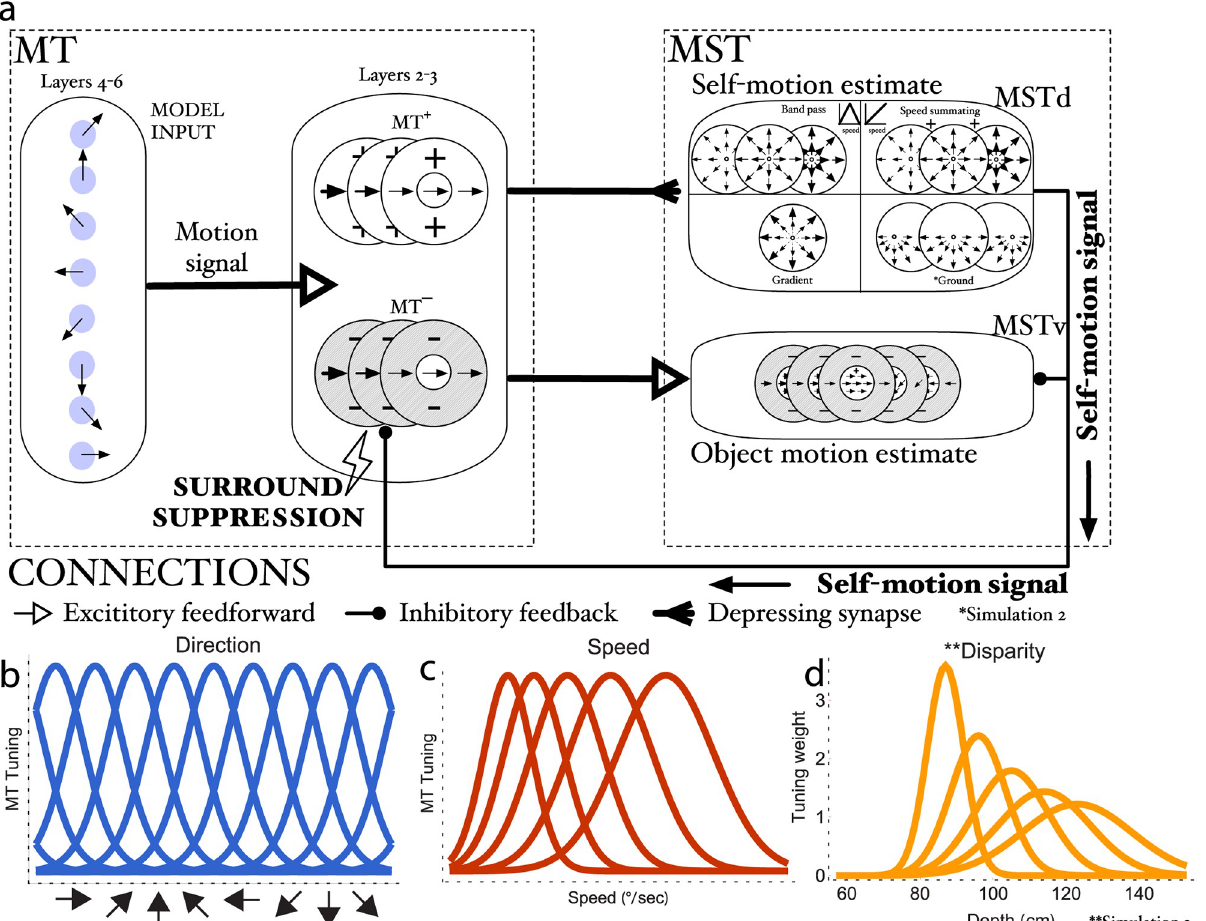
Fig 2. Diagram of model MT and MST. (a) The model contains two major pathways: MT + /MSTd subserves self-motion (top) and MT − /MSTv subserves object motion (bottom). The model is dynamic and estimates self-motion and object motion simultaneously. Cells in MSTd model physiologically supported populations tuned to full-field radial patterns, speed (band-pass, speed summating, gradient), and non-direction dependent disparities. Cells in MT − /MSTv have RFs with inhibitory surrounds due to local and feedback mediated suppression. Feedback comes from dominant MSTd units and suppresses MT − /MSTv units locally tuned to the direction, speed, and disparity that match the estimated self-motion motion pattern. This shifts population object motion responses from a retinal to world-relative reference frame. (b-d) Model MT tuning curves for direction (b), speed (c), and disparity (d). � MSTd units tuned to ground patterns were added in Simulation 2. �� Disparity tuning was incorporated in Simulation 3.